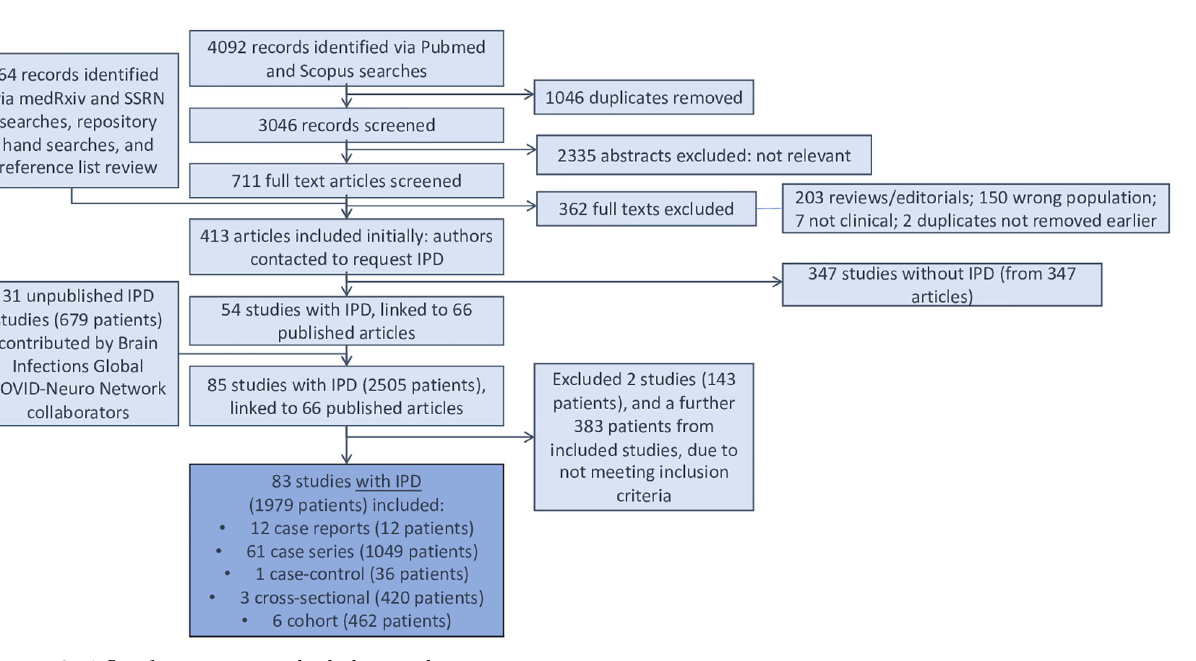
Fig 1. PRISMA flow diagram. IPD = individual patient